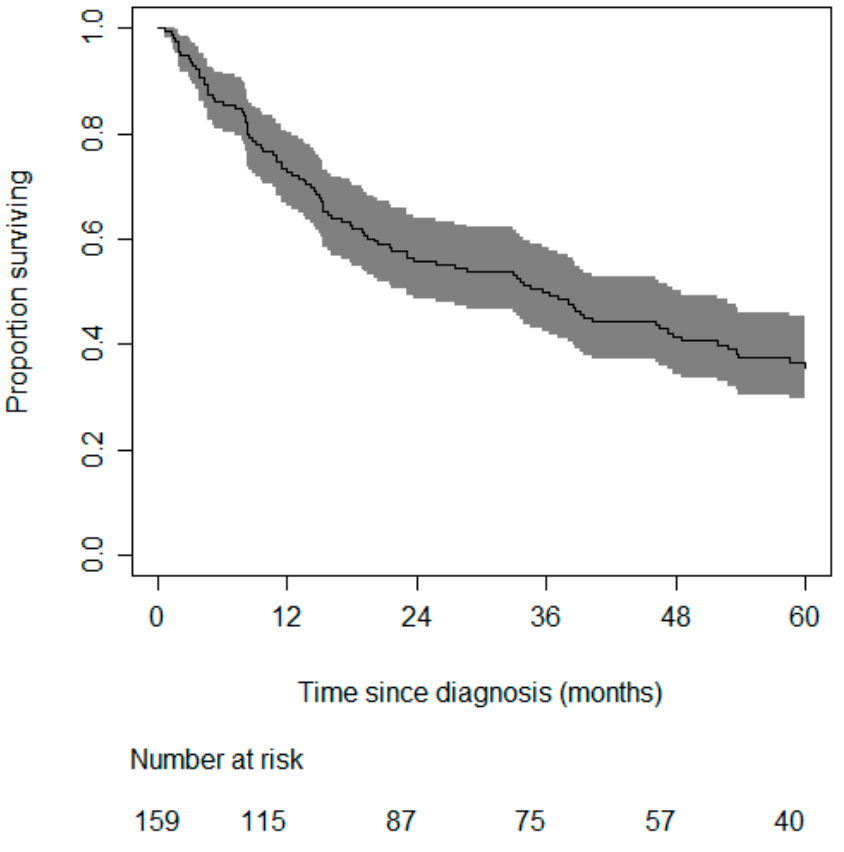
Figure 1. Kaplan–Meier curve, including 95% confidence band of the risk of adrenocortical carcinoma-related mortality. The numbers above the x -axis denote the number of patients still at risk at each point in time.